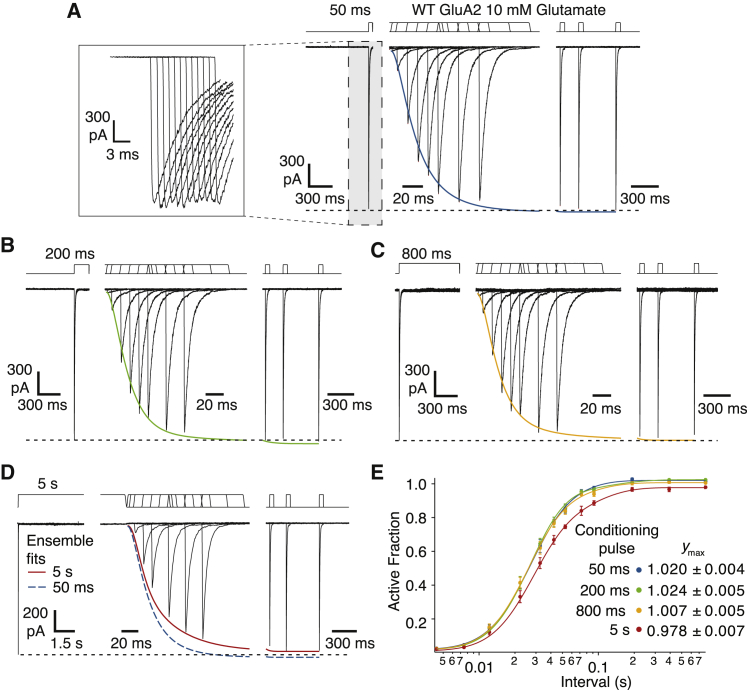
Recovery of WT GluA2. (A–D) Two-pulse protocols with conditioning pulses of 50 ms to 5 s. Inset (from gray boxed area) shows the typical consistency of responses to the conditioning pulse; responses were also highly consistent in their timing but are drawn displaced here. Ensemble fits to data with the two component H.-H. function (Eq. 3, see Materials and Methods). Conditioning pulses of 50 ms blue, 200 ms green, 800 ms orange, and 5 s red are overlaid on traces from immediate and late recovery responses (note changes of abscissa scale). Dashed black line indicates the responses to the conditioning pulse. In (D), the 50-ms ensemble fit is included as a dashed blue line. Note that the 5-s ensemble fit (red) did not reach the amplitude of the response to the conditioning pulse. The interval between episodes was typically 1 s. (E) Ensemble fits with Eq. 3 (H.-H. with two components). The slope of the fast component was fixed to 4, and the slope of the slower component was fixed to 2. Fitted maxima are shown. For the 5-s conditioning pulse, a1 = 0.7, k1 = 71 s−1 and a2 = 0.27, k2 = 19 s−1 with maximum 0.978 as shown. Alternative fits and fit parameters with errors are shown in Figs. S1 and S2 and Tables S1 and S2. To see this figure in color, go online.